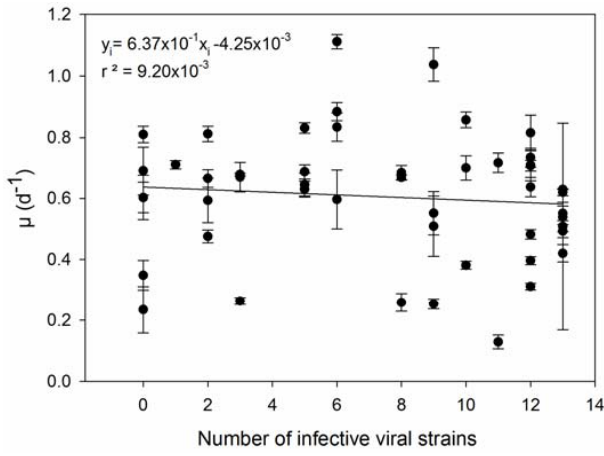
Figure 2. Resistance capacity R 2 (number of viral strains infecting each algal strain) plotted against growth rate ( µ ). Error bars show standard deviation ( n = 3).